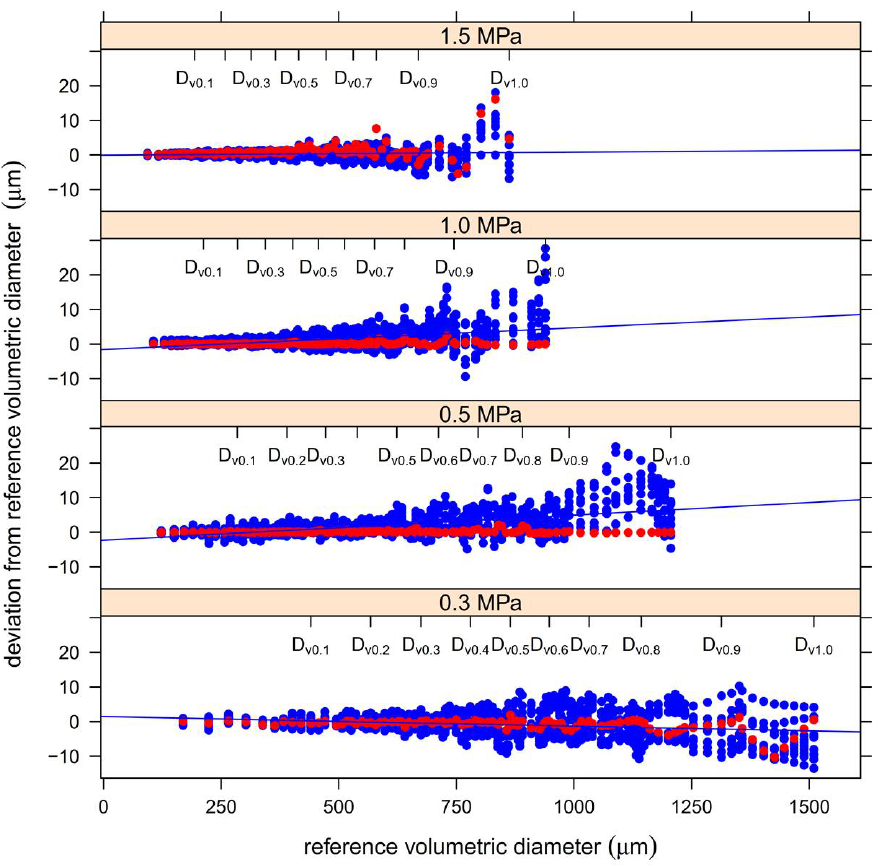
Figure 7. Deviations from reference volumetric diameters at varying pressure (red points denote TV ∗ threshold).